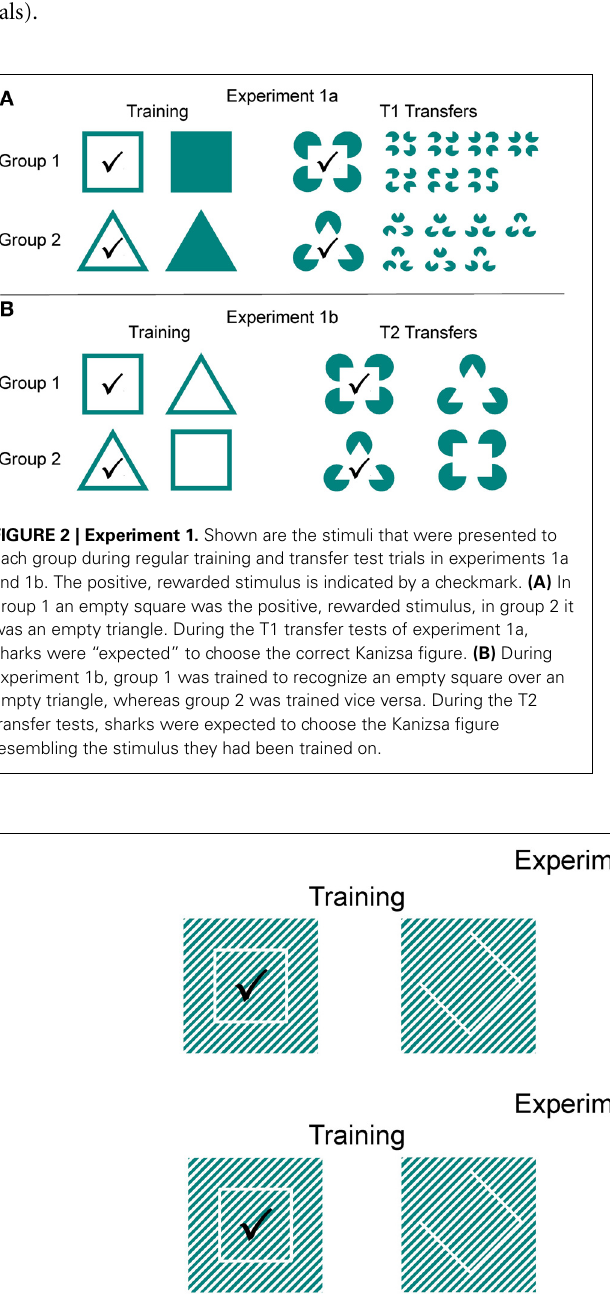
expected to choose the subjective contour defining a square by using grating gaps within the white lines; during T4 transfer tests (2b), sharks were expected to choose the subjective contour defining a square by using phase-shifted abutting